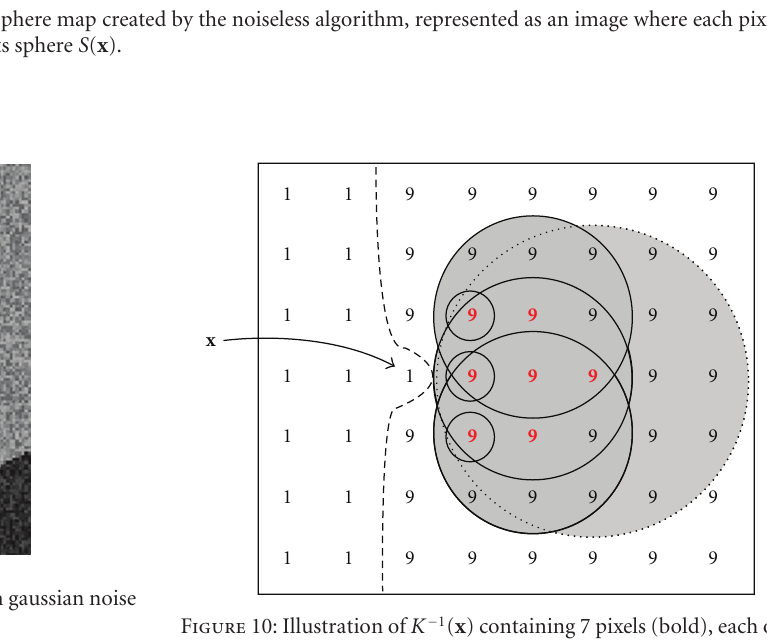
Figure 10: Illustration of K − 1 ( x ) containing 7 pixels (bold), each of whose spheres would place its reflector across the boundary at x